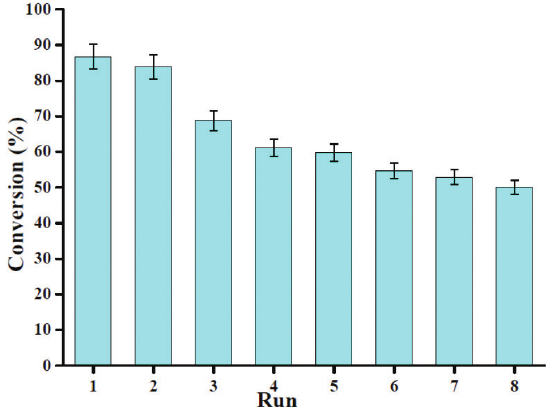
Figure 7: Reusability performance of the NiHSiW/UiO-66 nanocatalyst on the conversion of the esterification reaction (molar ratio of oleic acid to methanol: 1:18, catalyst amount: 180 mg, reaction temperature: 160°C, and reaction time: 3.0 h).